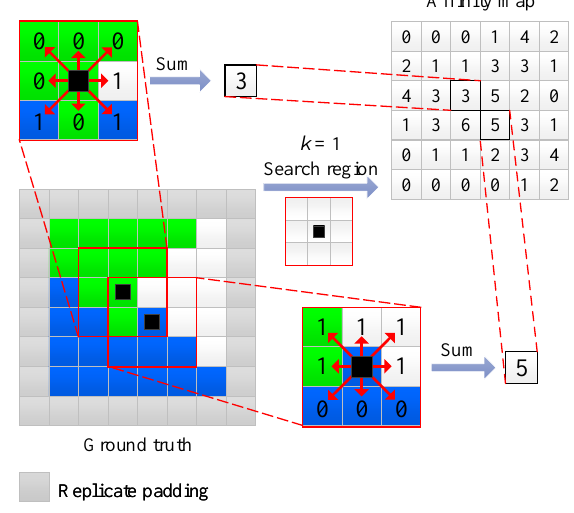
Figure 3. Illustration of how neighboring pixel affinity map calculated when search region k = 1 . The ground truth map is padded with the values from edge